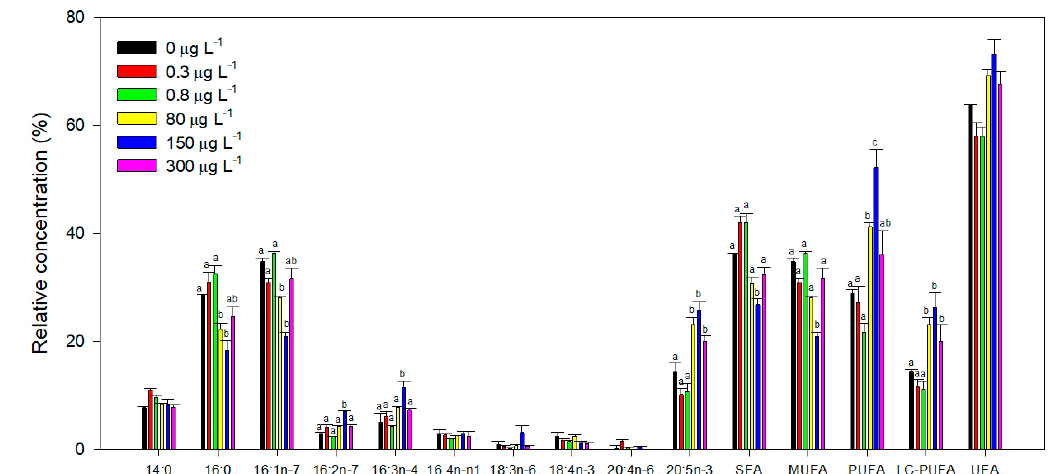
Figure 8. Fatty acid relative concentration (%) and saturation class abundance (%, SFA—Saturated Fatty Acids; MUFA—Monounsaturated Fatty Acids; PUFA—Polyunsaturated Fatty Acids; LC-PUFA—Long Chain Polyunsaturated Fatty Acids; UFA—Unsaturated Fatty Acids) in Phaeodactylum tricornutum cultures exposed to different propranolol concentrations (average, n = 3, letters denote differences at p < 0.05).